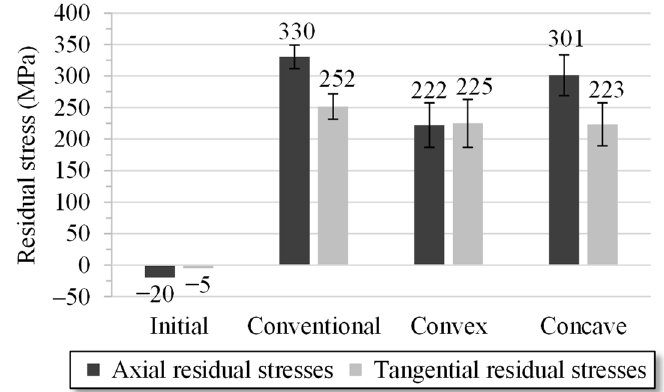
Figure 10. XRD-Measurements: Average residual stresses of the specimens drawn with conventional, convex, and concave die geometry variants (four measuring points on the circumference 0°, 90°, 180°, and 270°; three specimens per variant).